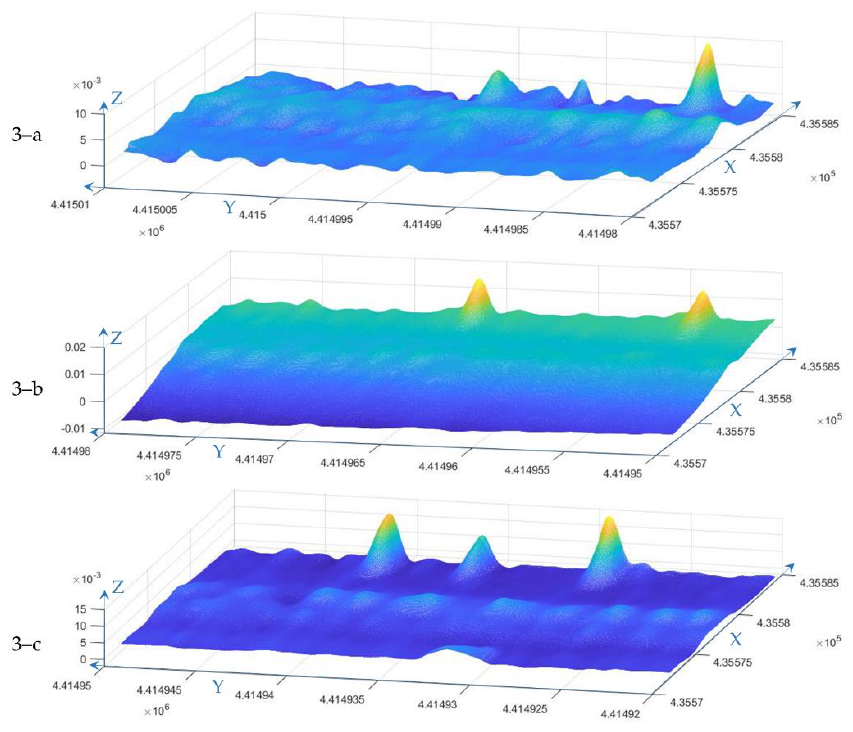
Figure 18. Three-dimensional views of the subregions in Figure 17.